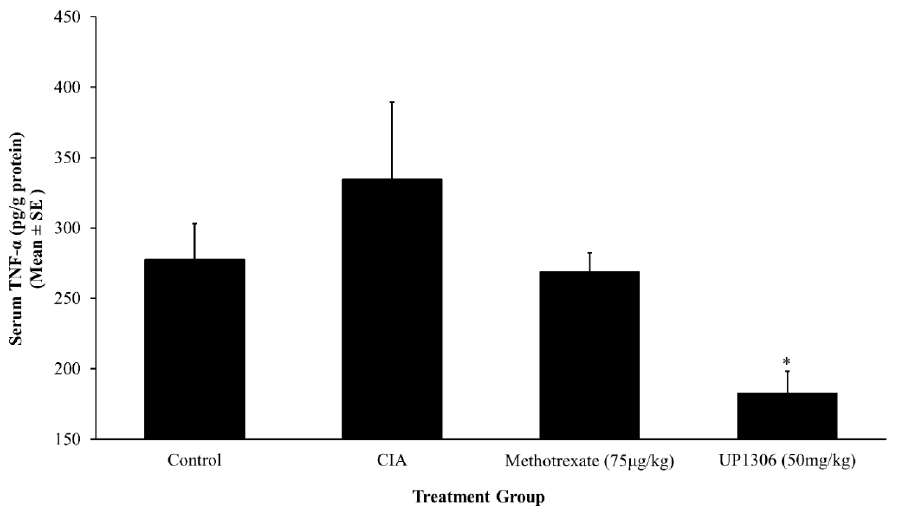
Figure 6. Effect of UP1306 on rat serum tumor necrosis factor α (TNF- α ) level normalized with protein in CIA model treated for three weeks post immunization. Data are Mean ± SE. * p ≤ 0.05 vs. vehicle treated CIA.